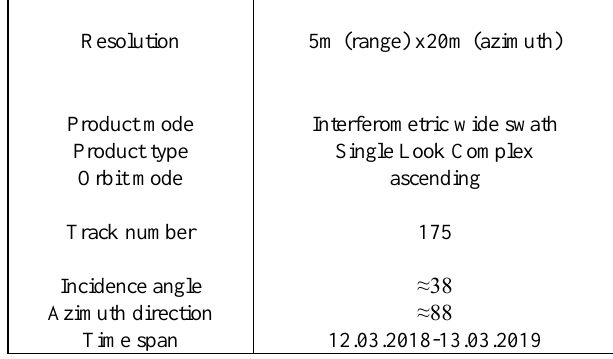
Table 1. The metadata of used Sentinel-1